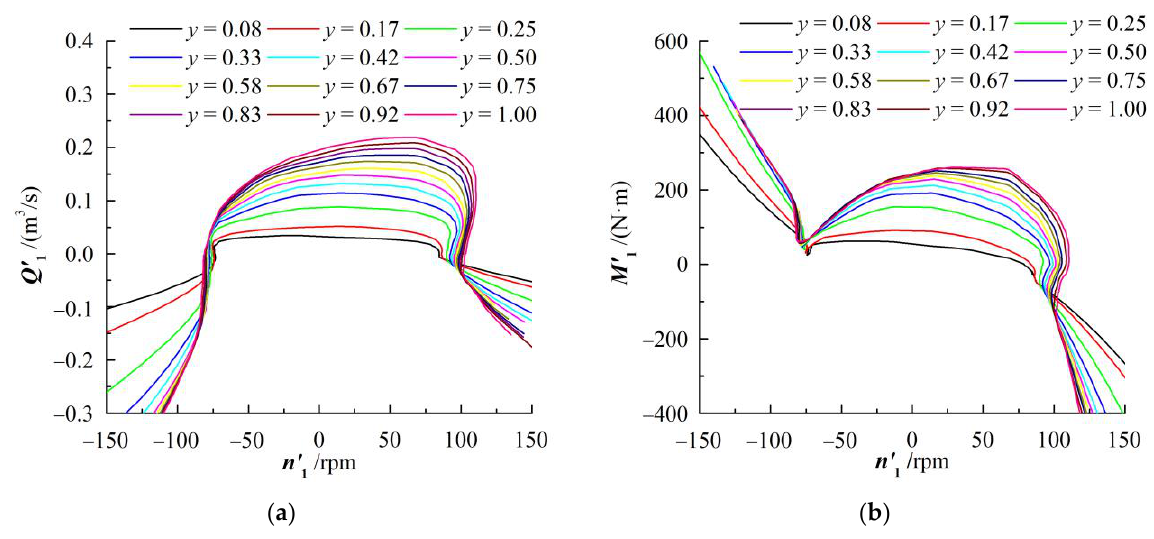
− Q (cid:48) − M (cid:48) curves. ( b ) n (cid:48) curves. 1 1 1 1